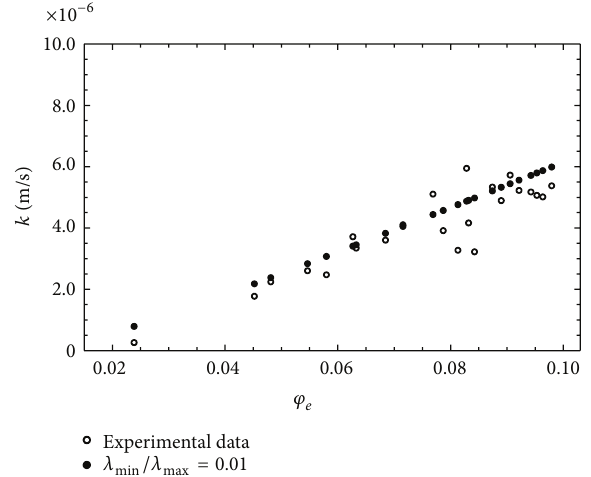
Figure 6: Fitting law according to the Xu and Yu [36] model for /𝜆 = 0.01 . 𝜆 min max